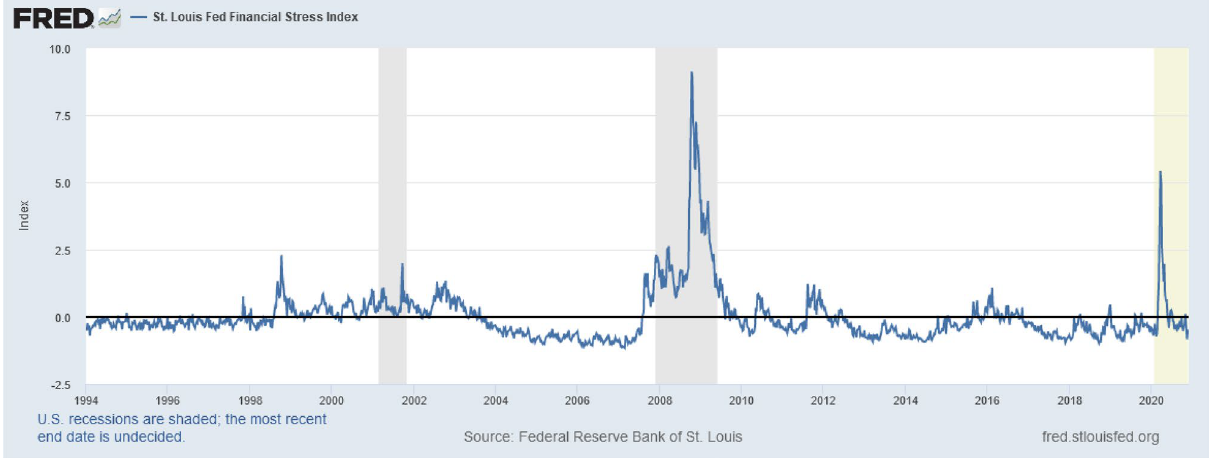
Figure 3. Financial stress index STLFSI2. USA recessions correspond to shaded areas. (Source: FRED 48